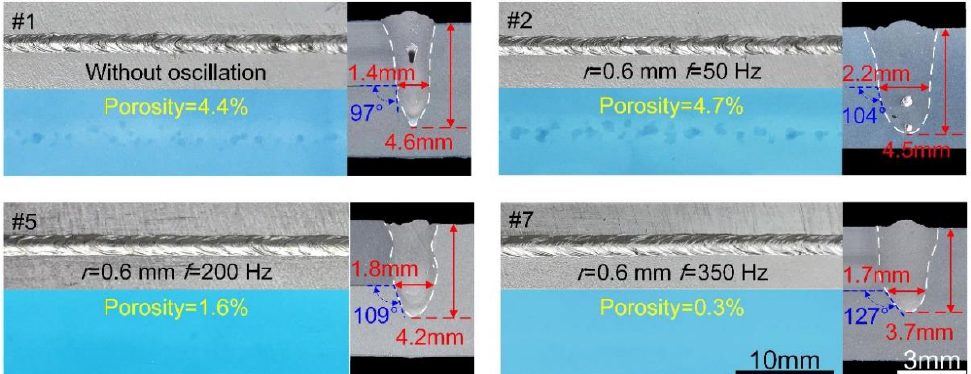
Figure 3. Weld morphology, P = 3.0/3.5 kW, v = 2 m/min.